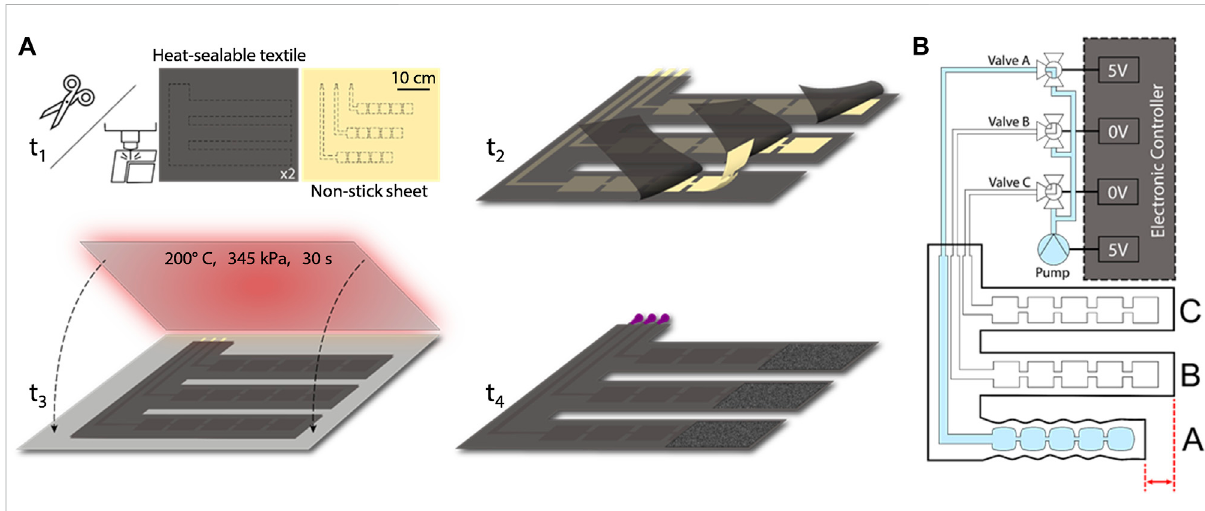
FIGURE 2 (A) Fabricationprocessincludescutting,aligning,heatpressing,andaddingpneumaticcomponents. (B) Schematicofthedeviceandcontroller showstheelectricalconnectionsthatpowerthemicropumpvalvesandthepneumaticconnectionstothestraps;here,thecontroller activatesvalve A, enabling pressure to increase within strap